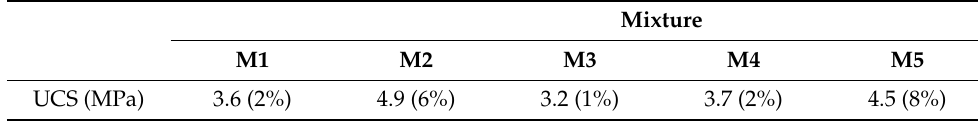
Table 2. Average UCS of the tested mixtures (CoV in